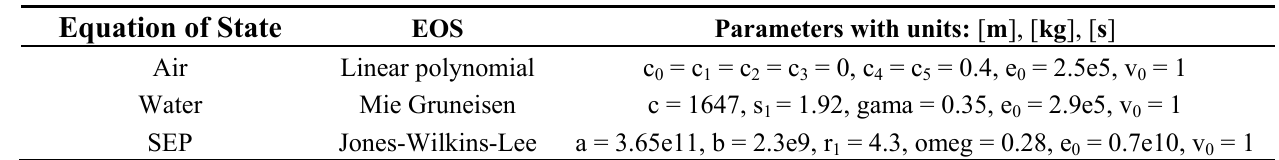
Table 1. Parameters of the equations of